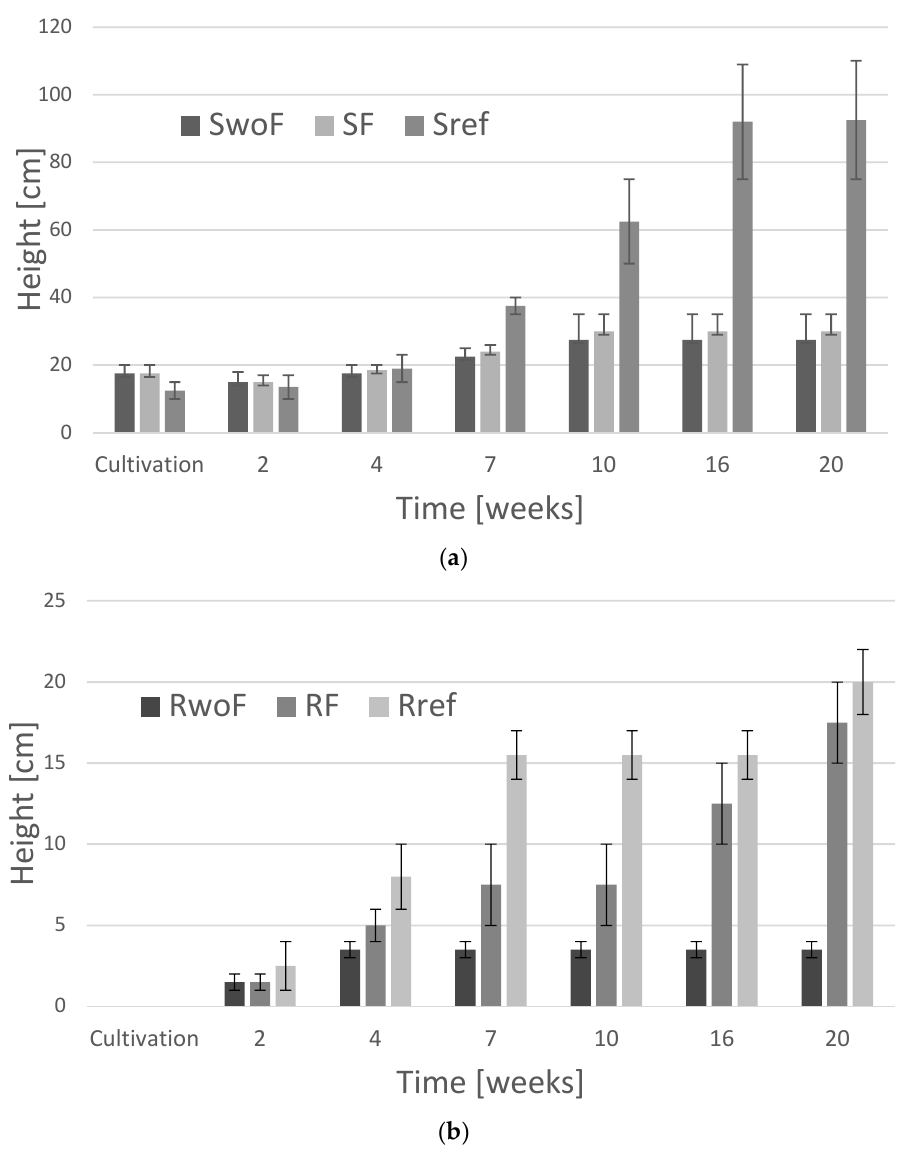
Figure 2. Average growth in cm for ( a ) sunflowers and ( b ) rapeseed cultivated in MIBA or reference soil (Sref and Rref) over 20 weeks. Error bars indicate variations in height.